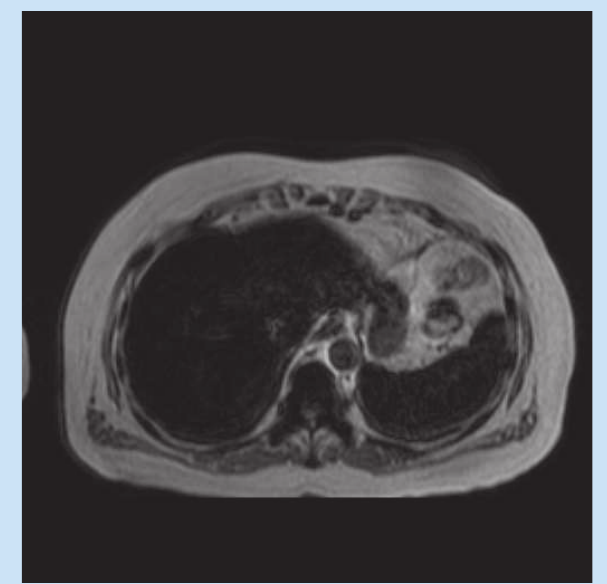
Fig. 2. Unenhanced CT scan of the liver showing a hyperdense liver with an HU of 103 (normal value 54 - 60 1 ), with normal density of the spleen.